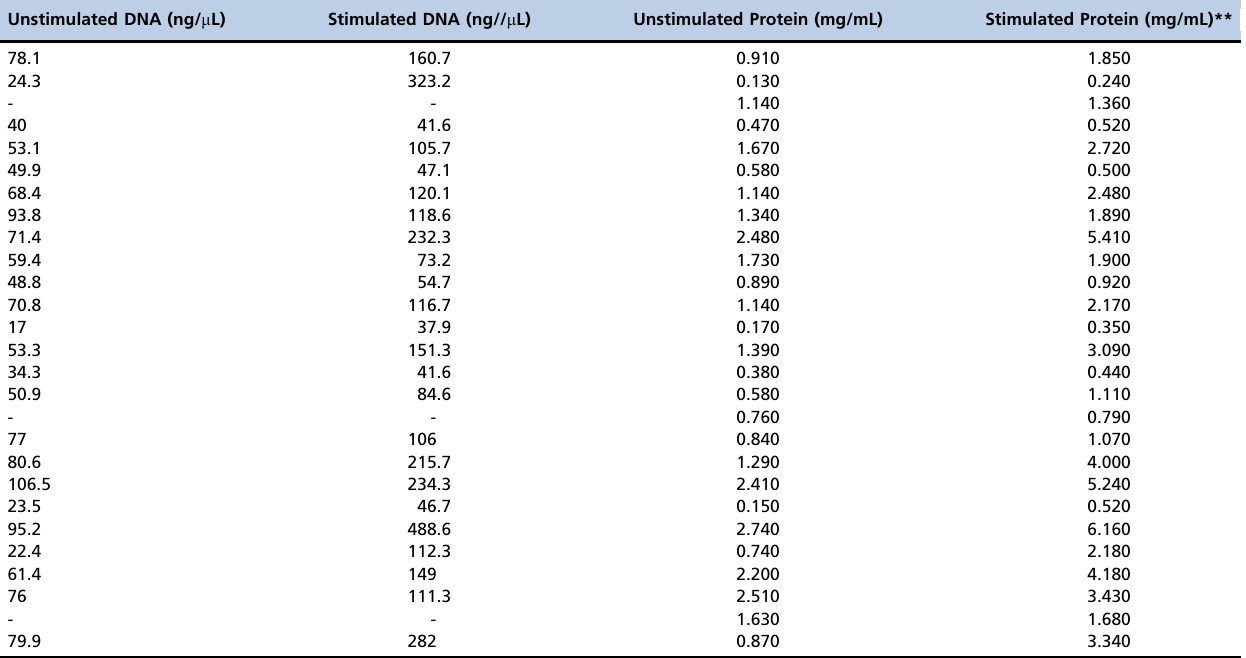
Table 1 - Protein and DNA Quantity in Unstimulated and PHA-stimulated PBMCs after Culture Measured by NanoDrop. Unstimulated DNA (ng/ m L) Stimulated DNA (ng// m